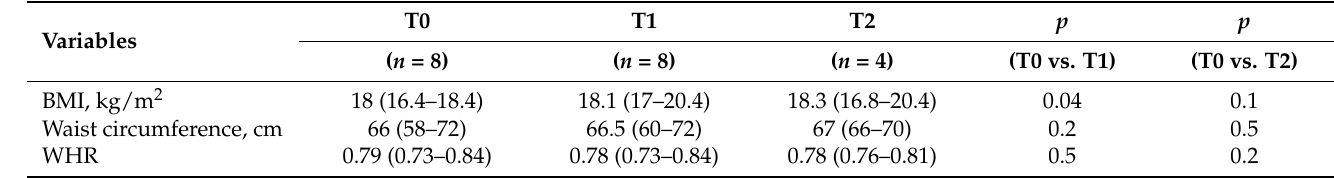
Table 4. Anthropometric parameter changes in women